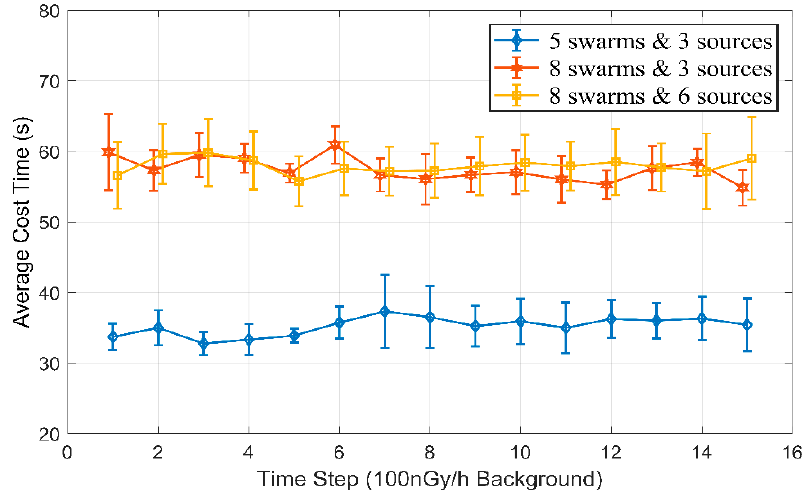
Figure 11. The processing runtime with different swarm number and source number cases.